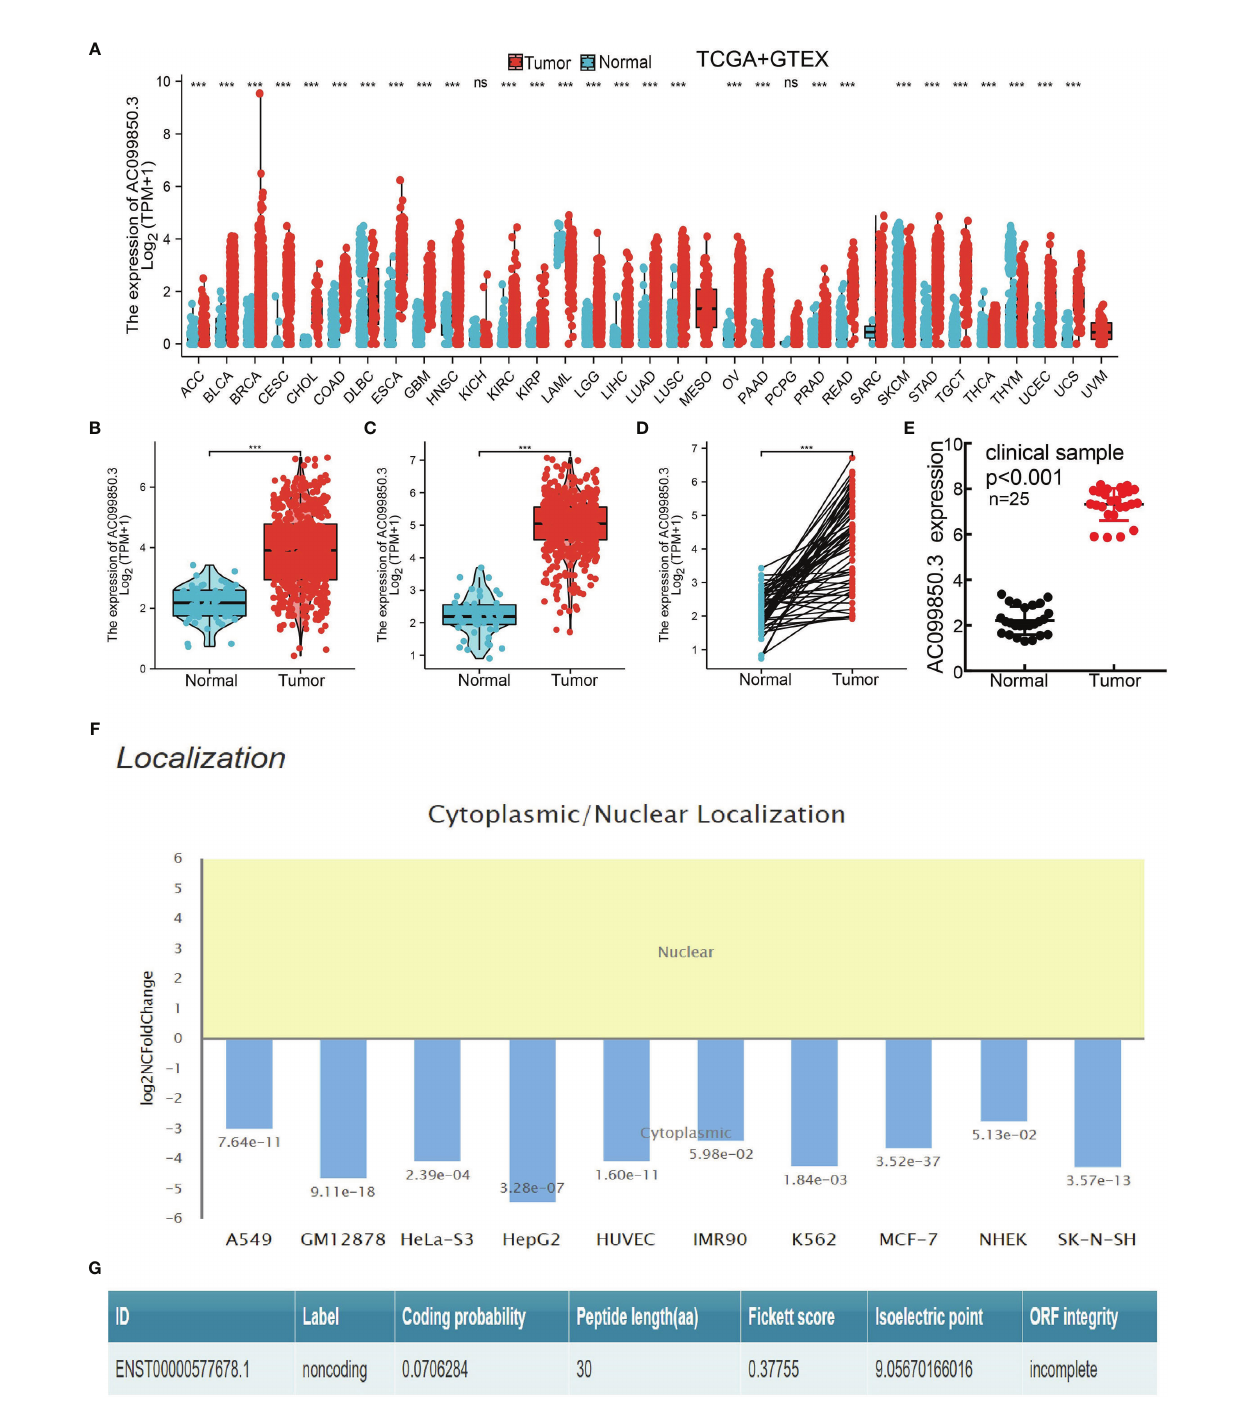
FIGURE 1 | AC099850.3 was overexpressed in LUAD. (A) The expression of AC099850.3 in pan-cancer examined by TCGA. (B – D) AC099850.3 was overexpressed in LUAD and LUSC examined by TCGA. (E) Relative AC099850.3 expression detected by RT-qPCR in 25 paired lung cancer and noncancerous tissues. (F) The subcellular distribution of AC099850.3 in A549 cells was determined by annolnc2 database. (G) The coding probability of AC099850.3 was assessed by CPC database (NS: P> 0.05,